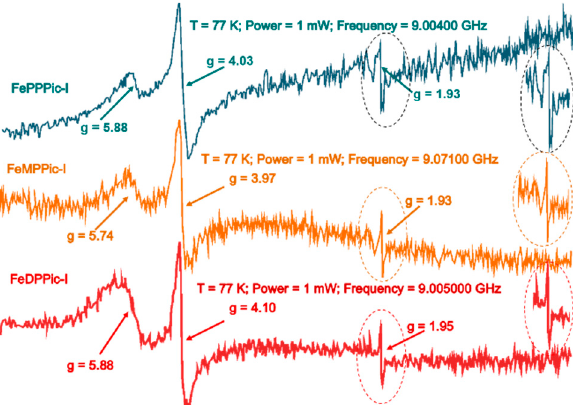
Figure 8. ESR axial spectra of [PPicdienFe IV =O] +· with species of iron ion at higher energy with qms